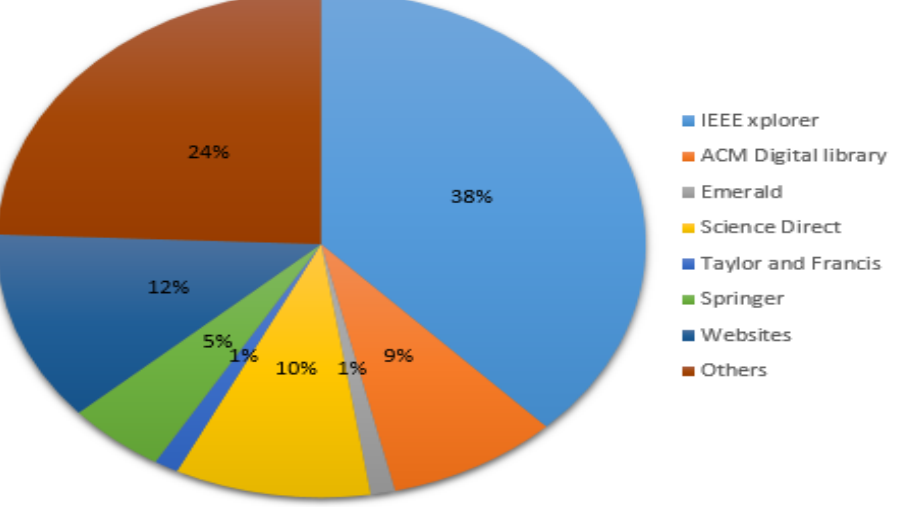
Figure 2. The percentage of research papers read from multiple sources.